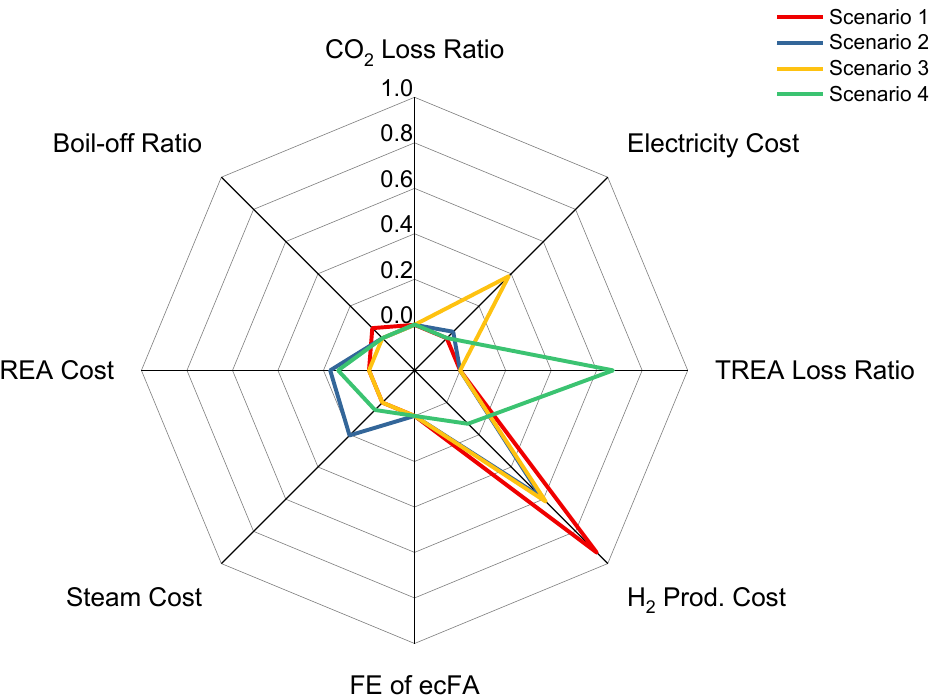
Figure 3. GSA result of the eight different parameters simultaneously analyzed within a defined variable